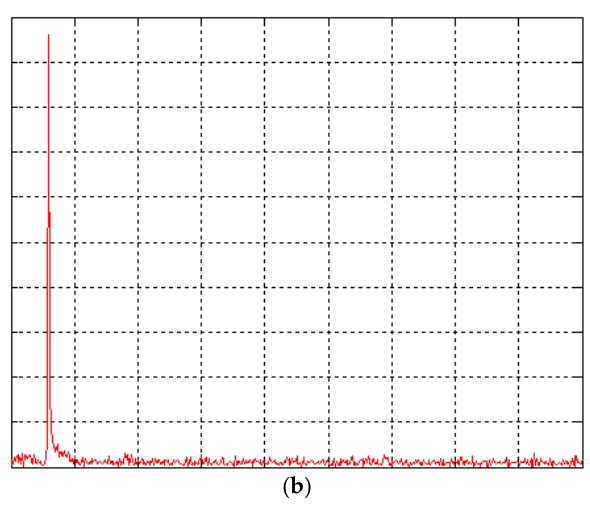
Figure 4. ( a ) Simulation waveforms of the output voltage and output current under nonlinear load for the proposed control technique (100 V/div; 20 A/div); ( b ) Harmonic spectrum of output voltage.